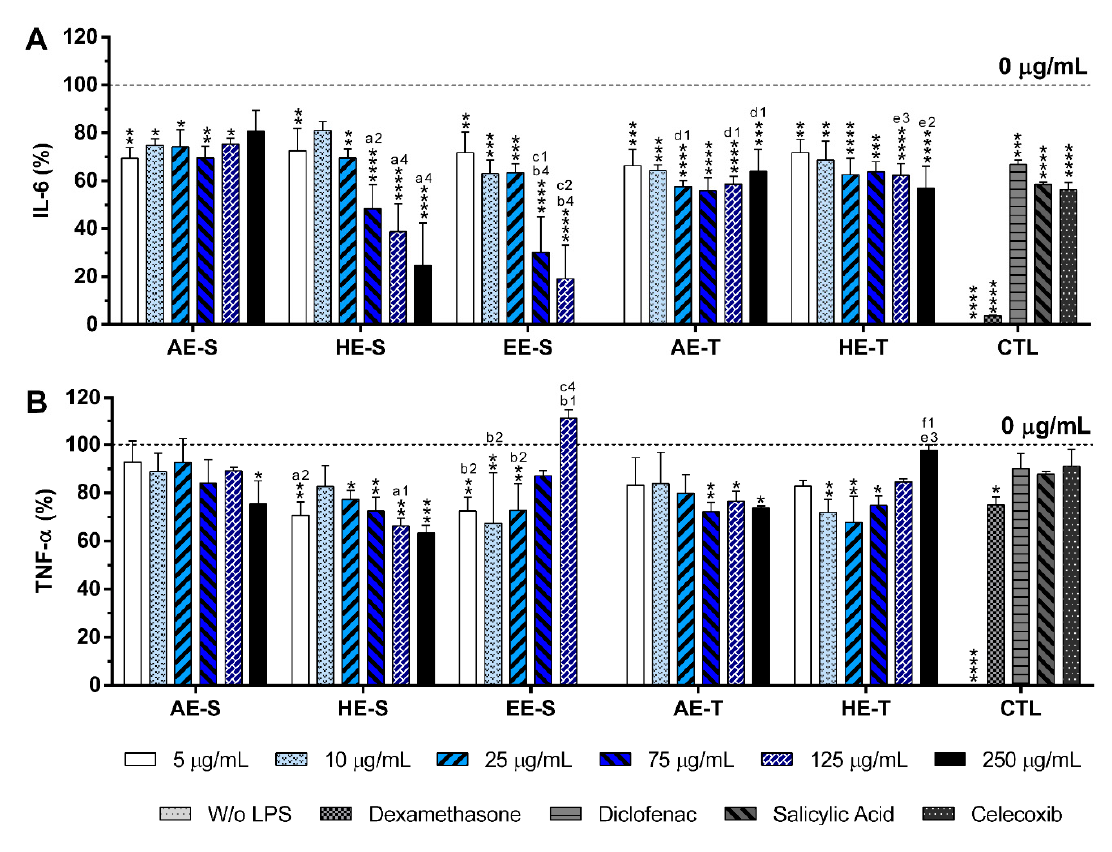
Figure 8. IL-6 ( A ) and TNF- α ( B ) percentages of LPS-stimulated macrophages cultured in the presence of different concentrations of the Salvia officinalis extracts and clinically used anti-inflammatory drugs (dexamethasone, diclofenac, salicylic acid, and celecoxib, 10 µM) for 24 h of culture at 37 °C. The dotted line represents the nontreated condition (0 µg/mL) for each assay. Statistically significant differences are * ( p < 0.0474), ** ( p < 0.0092), *** ( p < 0.0008), **** ( p < 0.0001) in comparison to the positive control (0 µg/mL) for each different tested extracted, and 1 ( p < 0.0381), 2 ( p < 0.0085), 3 ( p < 0.0009), and 4 ( p < 0.0001) in comparison with a (AE-S vs. HE-S), b (AE-S vs. EE-S), c (HE-S vs. EE-S),